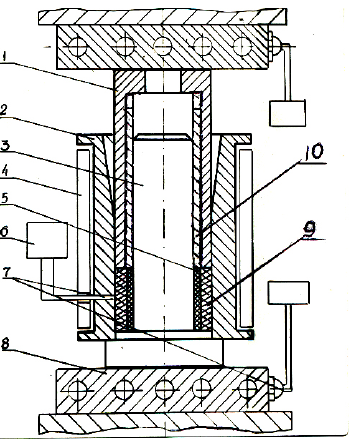
Fig.8 Scheme of a universal mold for restoring the inner diameter of plain bearings: a) thermosetting compositions; b) compositions based on fluoroplastic; c) coating the outer diameter with polyurethane (9). 1. sleeve, 2 - matrix, 3 - sign, 4 - matrix heater, 5 - primer composition, 6 - milliammeter, 7 - thermocouple, 8 - heater, 9 - outer sleeve made of stainless steel (polyurethane), 10 - punch.